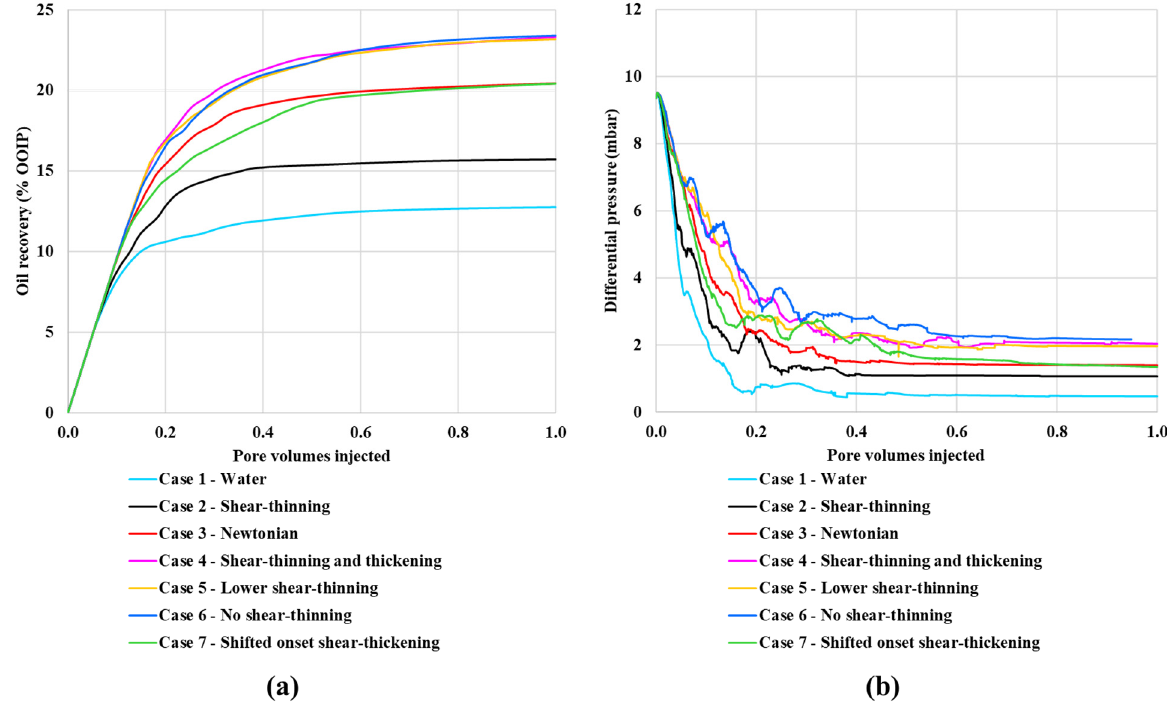
Figure 6. ( a ) Oil recovery and ( b ) differential pressure for pore network modelling with an injection rate of 1 × 10 − 12 m 3 /s as a function of pore volume injected. The differential pressure is the difference between inlet and outlet pressure of the network model, analogous to the experimental data.